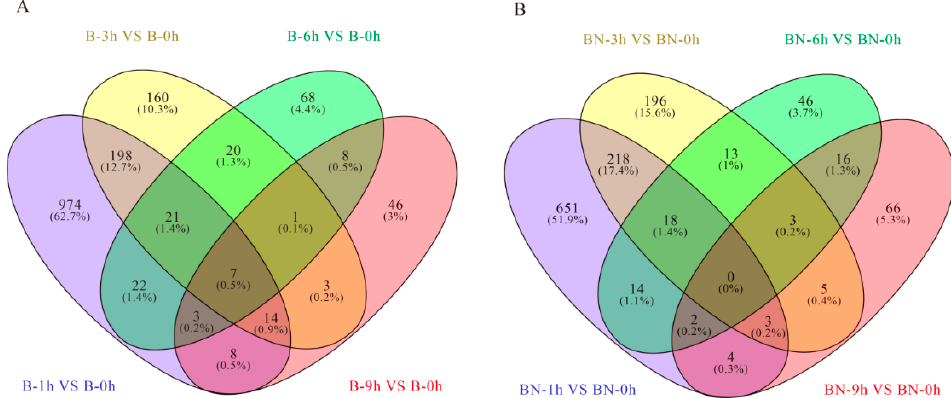
Figure 3. Venn diagrams showing the numbers of DEGs related to BmNPV infection in different resistant varieties. ( A ) Venn diagrams displaying the numbers of specific and shared DEGs in the B variety. ( B ) Venn diagrams displaying the numbers of specific and shared of DEGs in the BN variety.